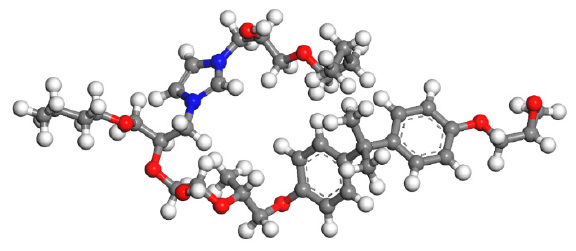
Figure 7. The model of epoxy resin cured with MC120D (colour legend: hydrogen H (white); oxygen O (red); carbon C (grey); nitrogen N (blue)).